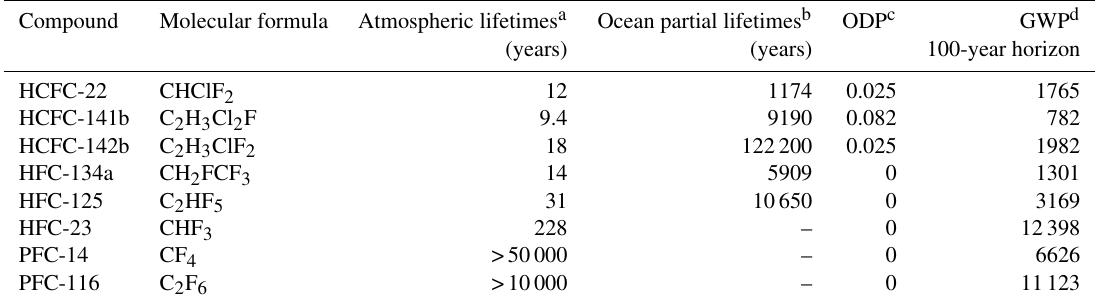
Table 1. Atmospheric lifetimes, ocean partial lifetimes, ozone depletion and global warming potentials of HCFC-22, HCFC-141b, HCFC- 142b, HFC-134a, HFC-125, HFC-23, PFC-14 and